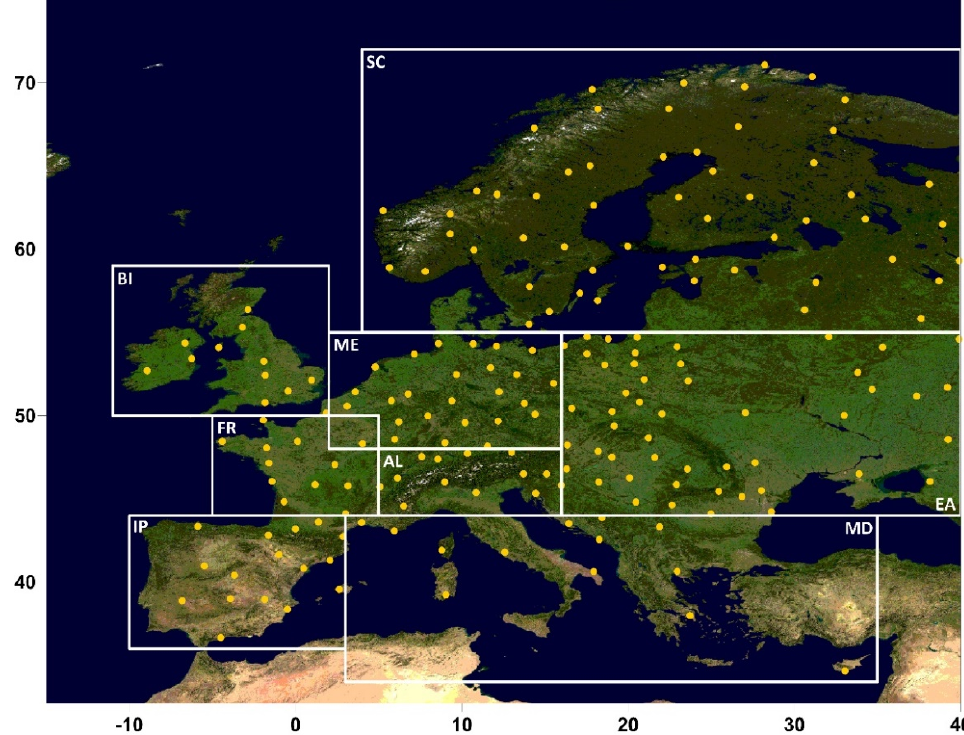
Figure 1. The 196 ECA&D stations used (yellow dots) and the division of the domain into eight smaller subregions (white lines). The subregions are: the Alps (AL), the British Isles (BI), Eastern Europe (EA), France (FR), the Iberian Peninsula (IP), the Mediterranean (MD), Mid-Europe (ME), and Scandinavia (SC) [24].